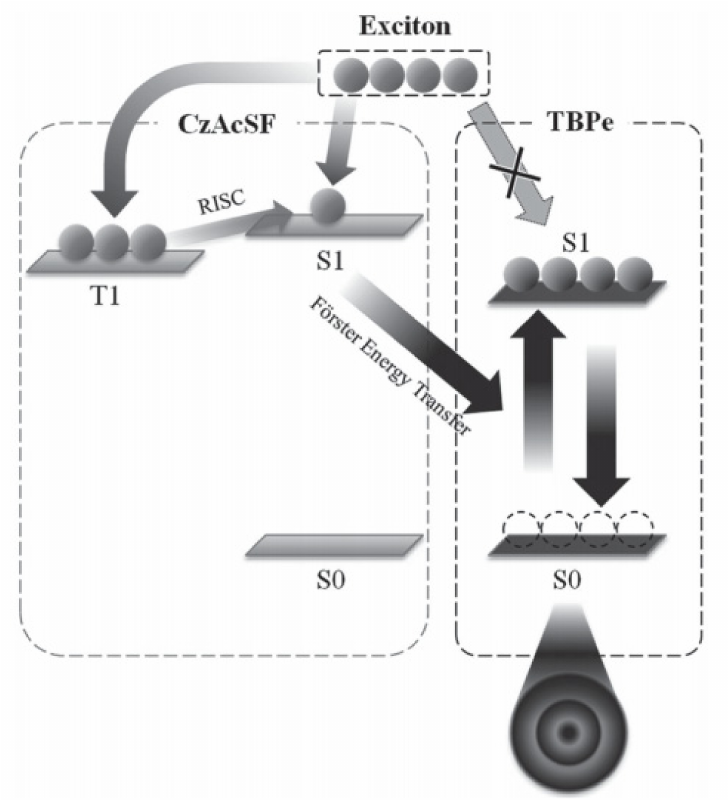
Figure 8. Schematic diagram showing the emission process of blue fluorescent device with a blue fluorescent emitter doped in a TADF host. Reproduced with permission from [138], John Wiley and Sons,